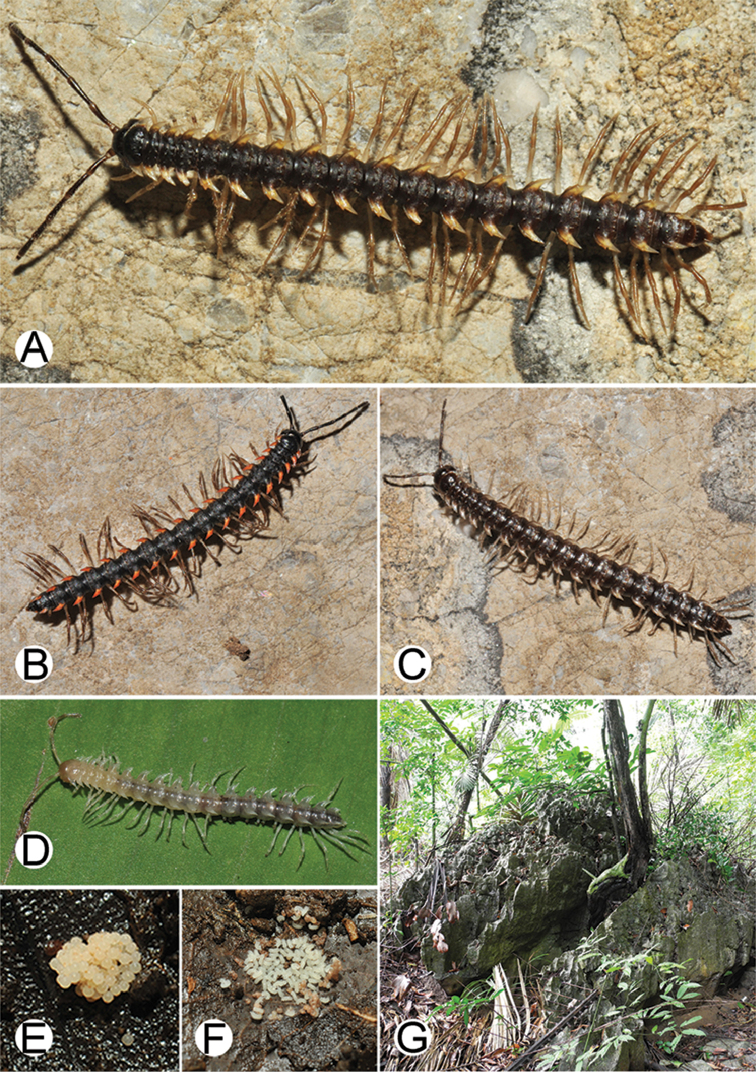
Photographs of live Desmoxytes
euros sp. n. and habitat. A, B male paratypes C female paratype D juvenile E egg cluster F cluster of stadium 1 juveniles G habitat.